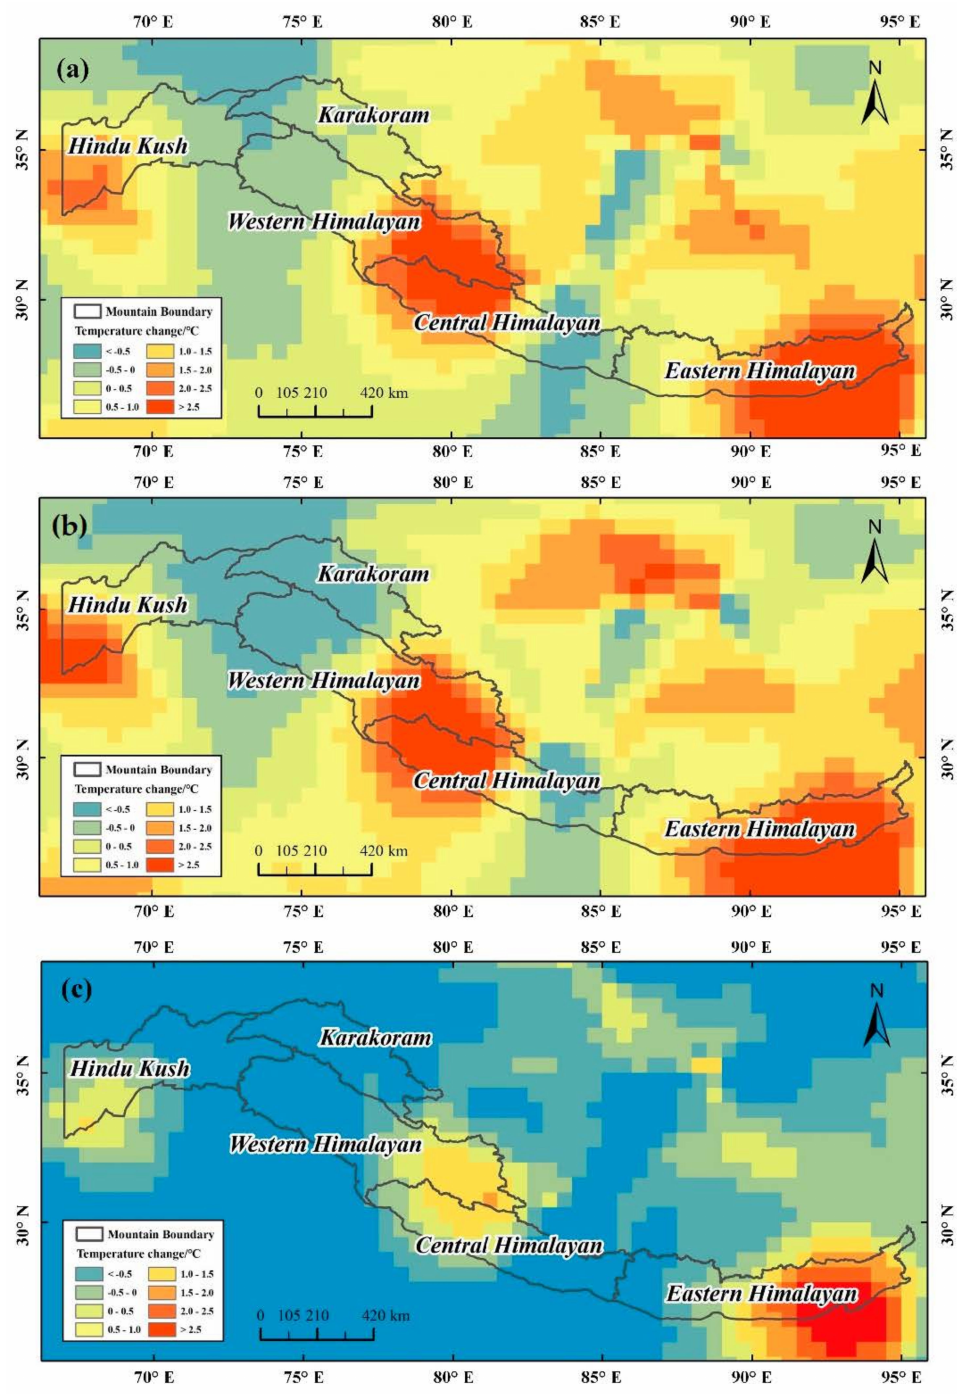
Figure 16. Temperature changes in the HKH-TMHA region: ( a ) changes in the annual daily tem- perature, ( b ) changes in the summertime daily temperature, and ( c ) changes in the wintertime daily